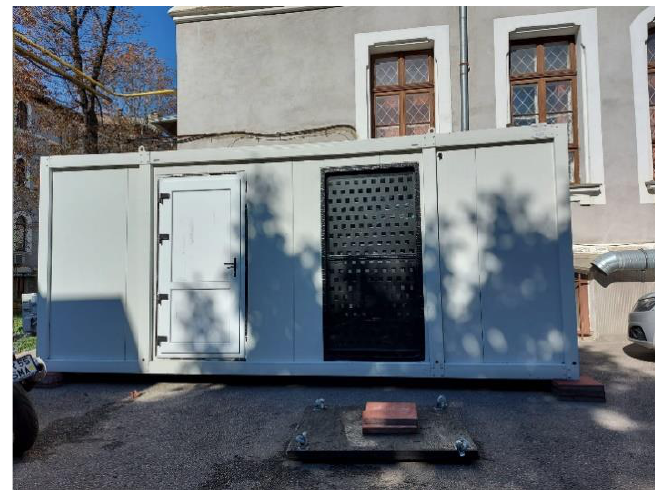
Figure 6. GTC on the façade of the experimental building.